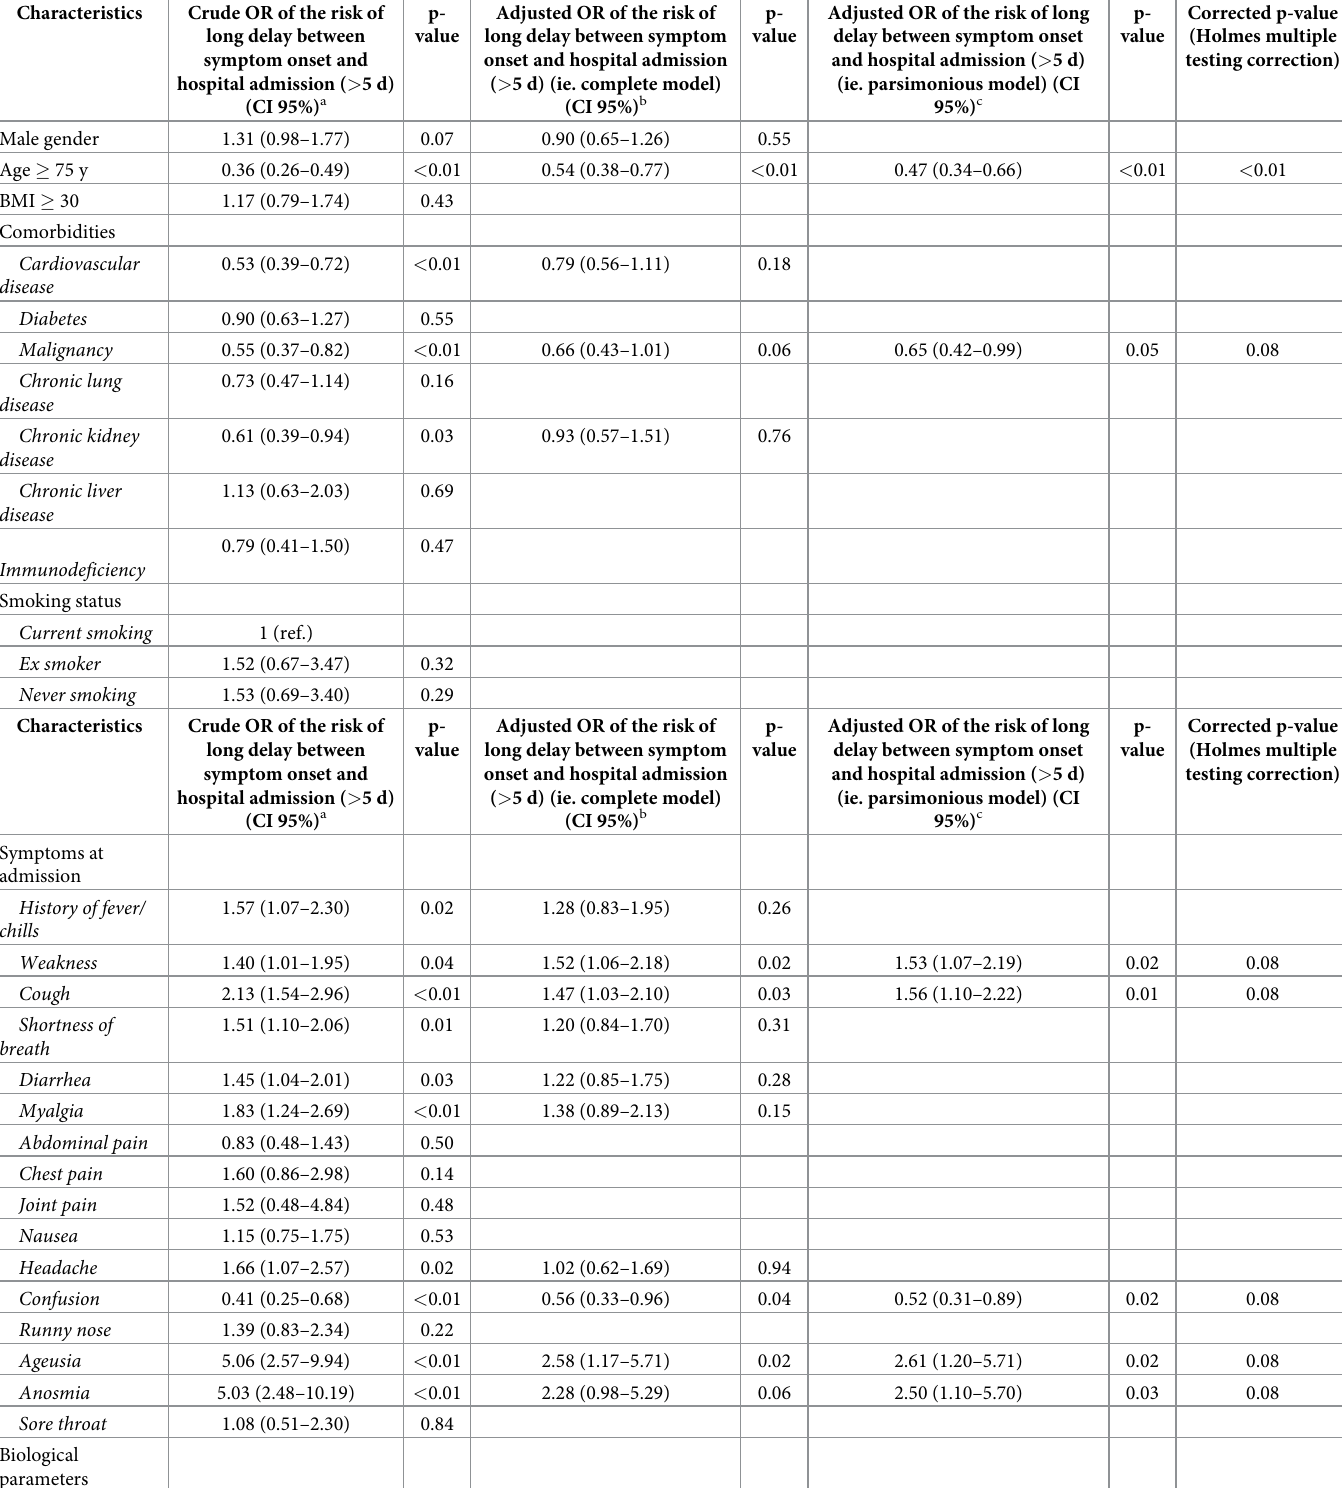
Table 2. Association between patient characteristics and delay between symptom onset and hospital admission, Lyon University Hospital (NOSO-COR Study), Feb- ruary 8–June 30, 2020.